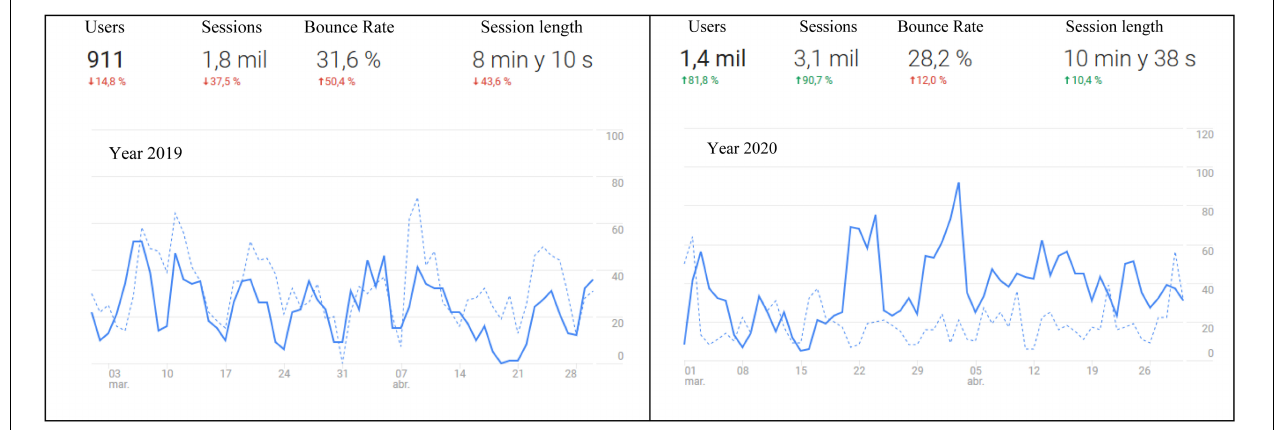
Frontiers in Psychology |